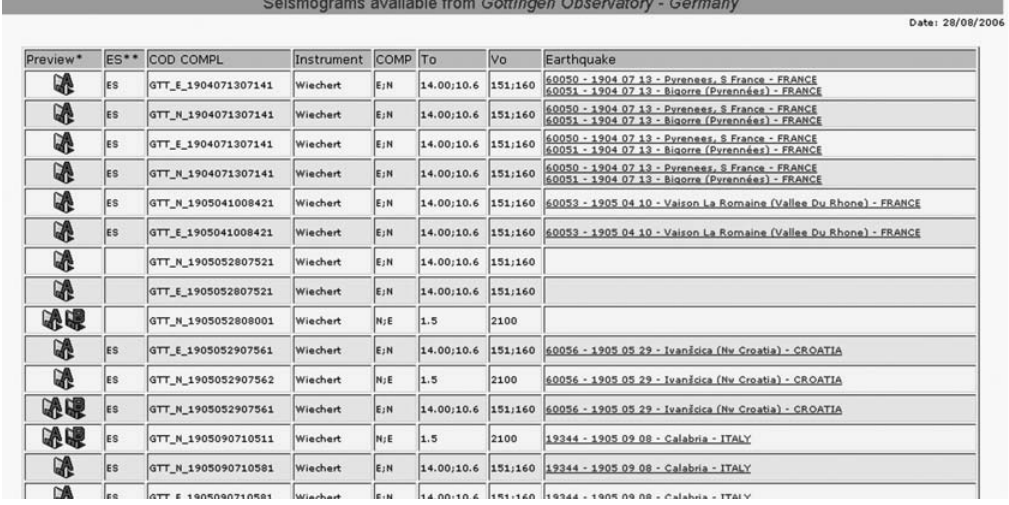
Fig. 12. From the «Seismograms Available» section of the ES Website, it is possible to know for each Obser- vatory the details relating to the scanned seismograms available in the SISMOS web site. From this section it is also possible to have low-resolution preview access of the seismograms, know the mean values of the main in- strumentals constants (from the TROMOS database) and know which earthquakes, among those chosen by the project partners, refer to each